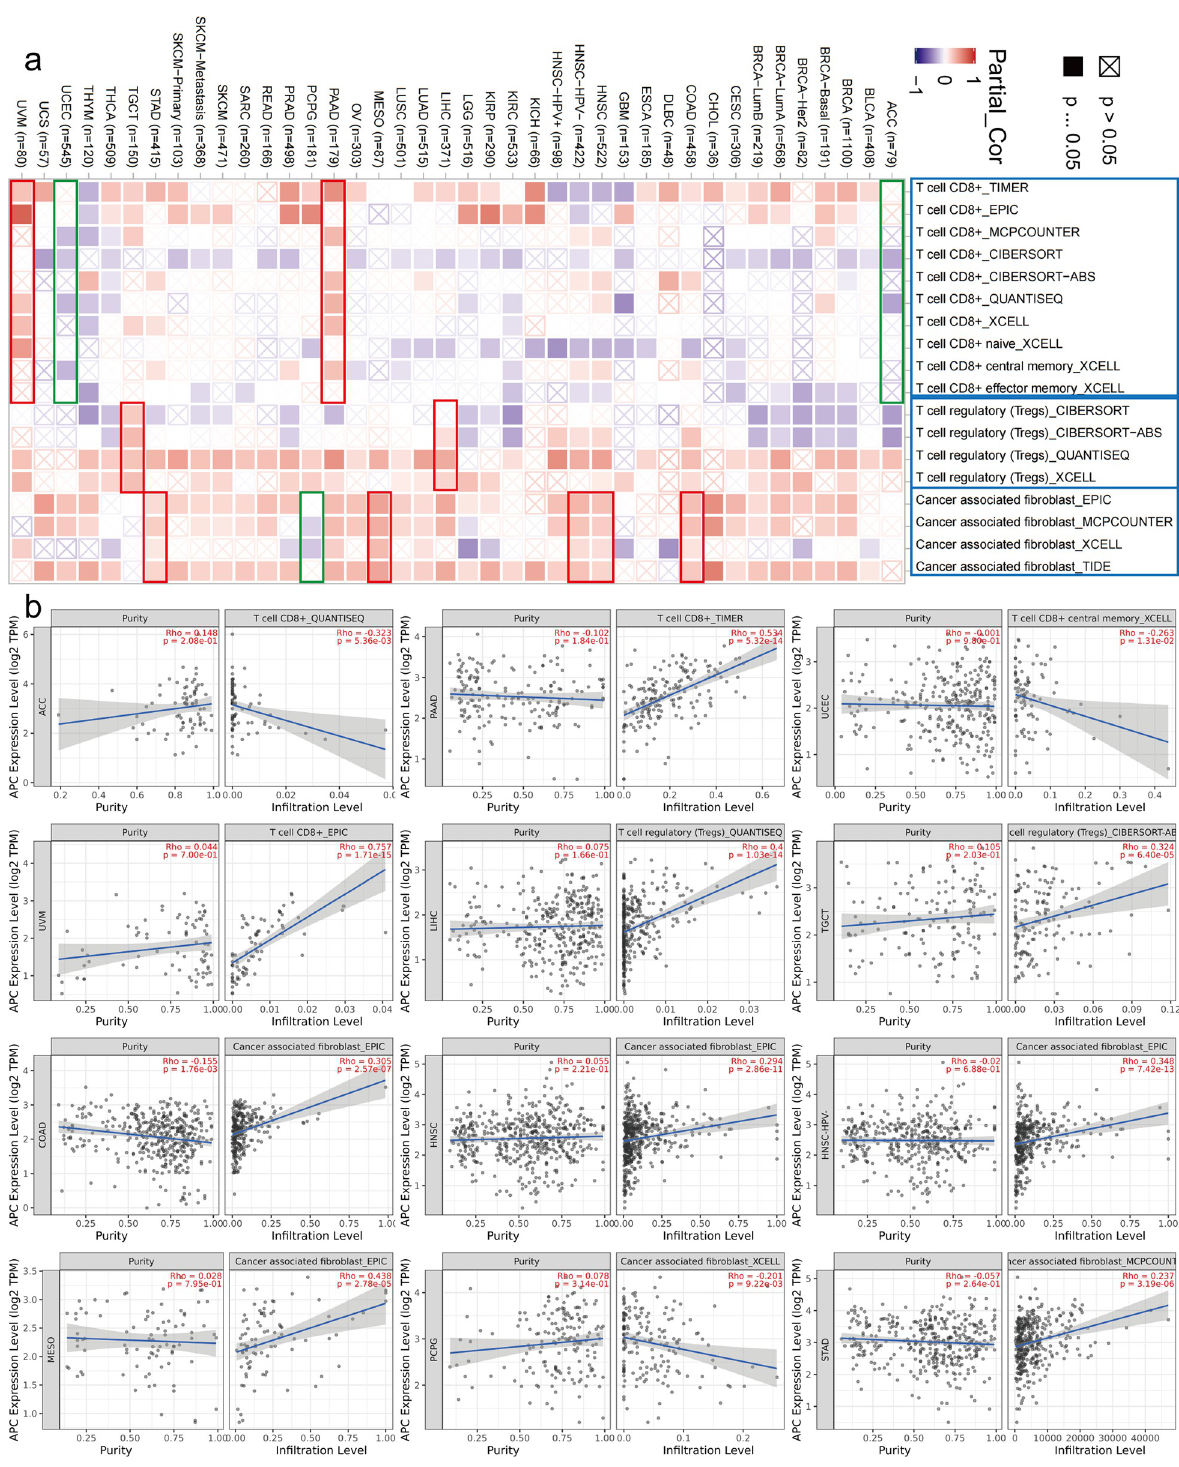
Fig 8. Immune infiltration analysis data between APC expression and immune infiltration. The heat maps and scatter plots of immune infiltration analysis data between APC expression and immune infiltration were displayed. The P -value and cor were supplied.